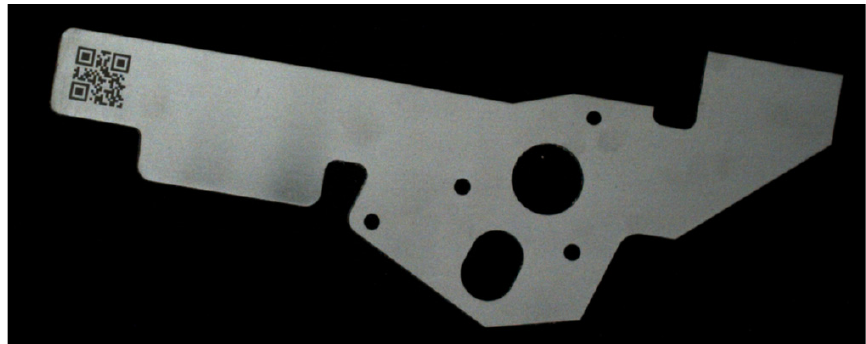
Figure 4. Irregular-shaped part.